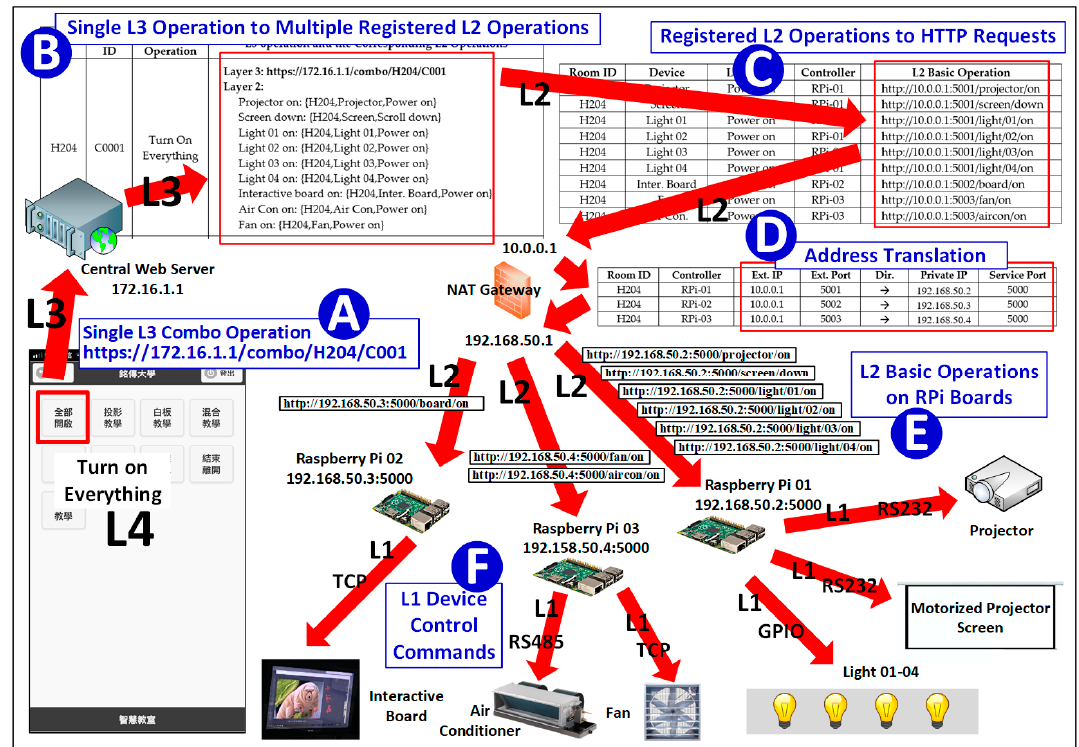
Figure 10. Operation flow in an implementation of the proposed model.